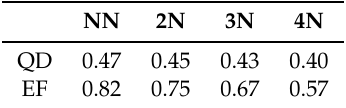
Table 1. Critical exponents of QD and EF for the NN, 2N, 3N and 4N pairs of spins. NN 2N